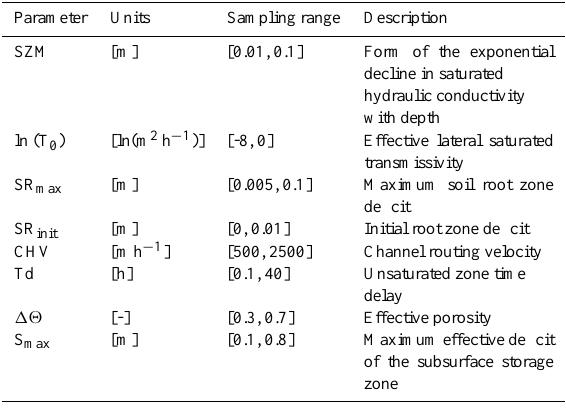
Table 2. Sampling ranges for dynamic TOPMODEL parameters. Parameter Units